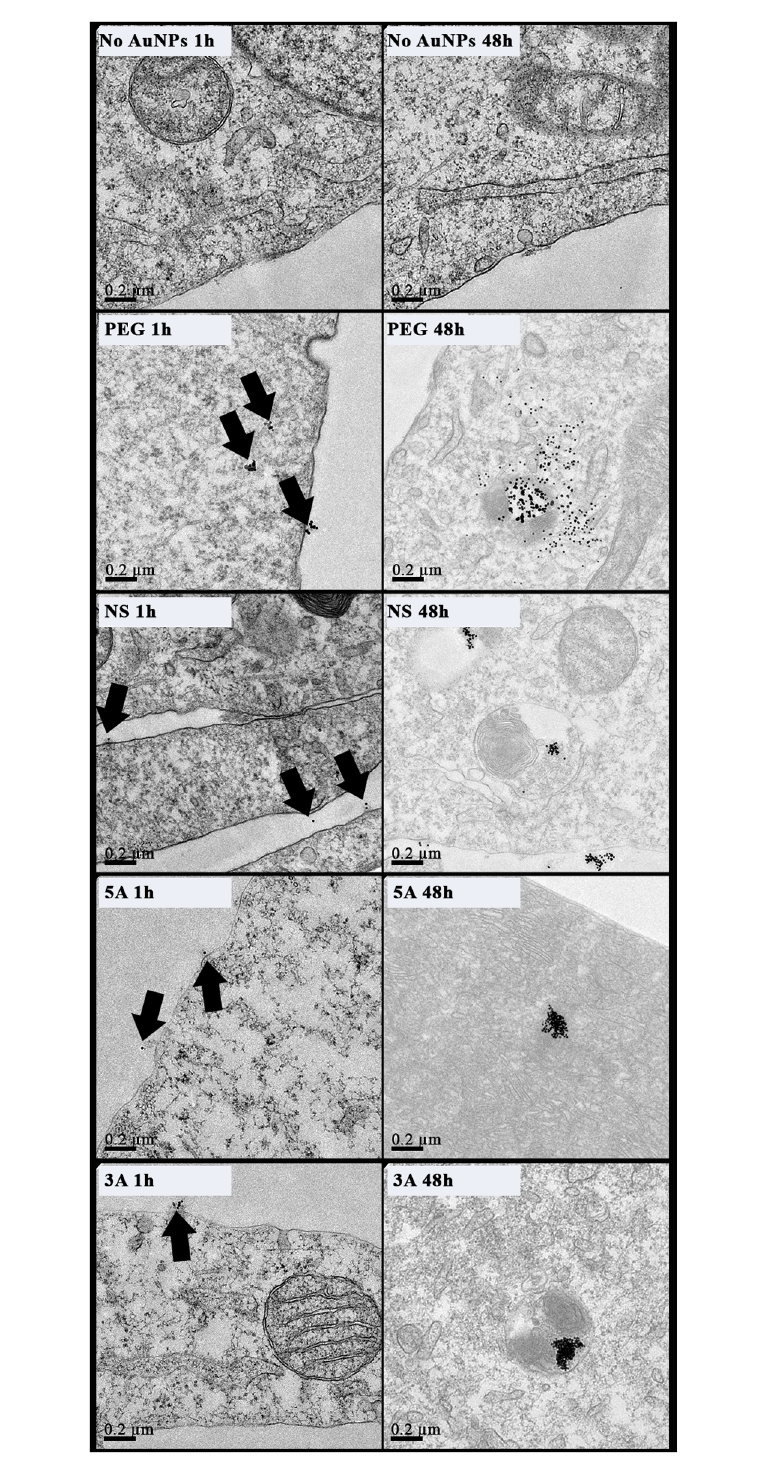
Fig 3. TEM images of MG63 cells treated with GNPs (50nM, 30% PEG) for 1 and 48 hours. Black arrowheads denote GNPs (n = 3 technical replicates; scale bar = 0.2μm).